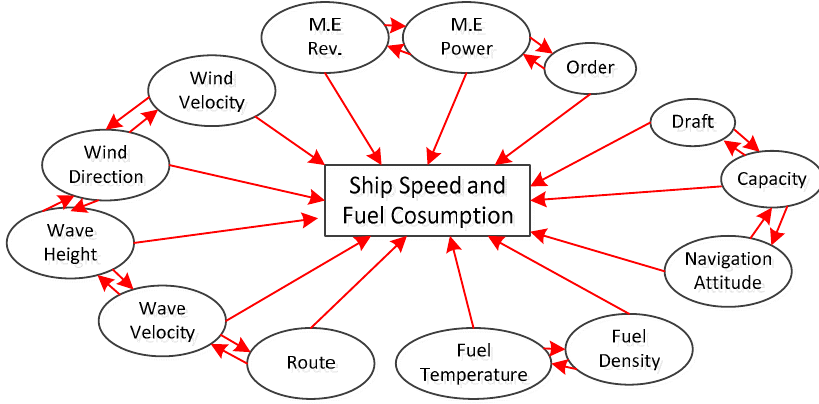
Figure 1. The main factors affecting ship speed and fuel consumption.